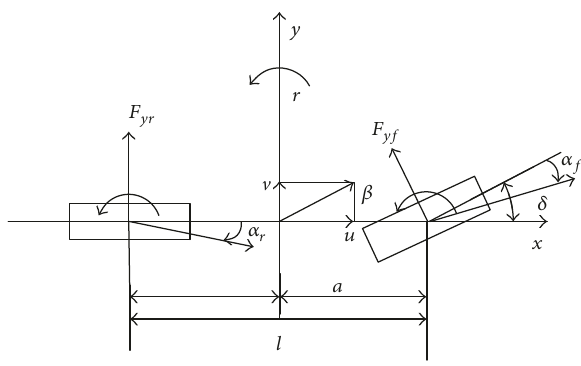
Figure 2: 2-dof vehicle dynamic model.